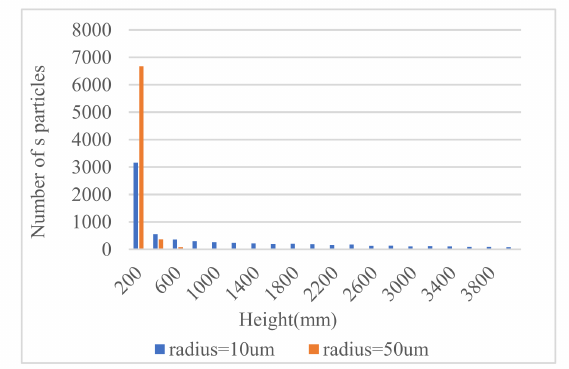
Figure 17. The number of particles by height at